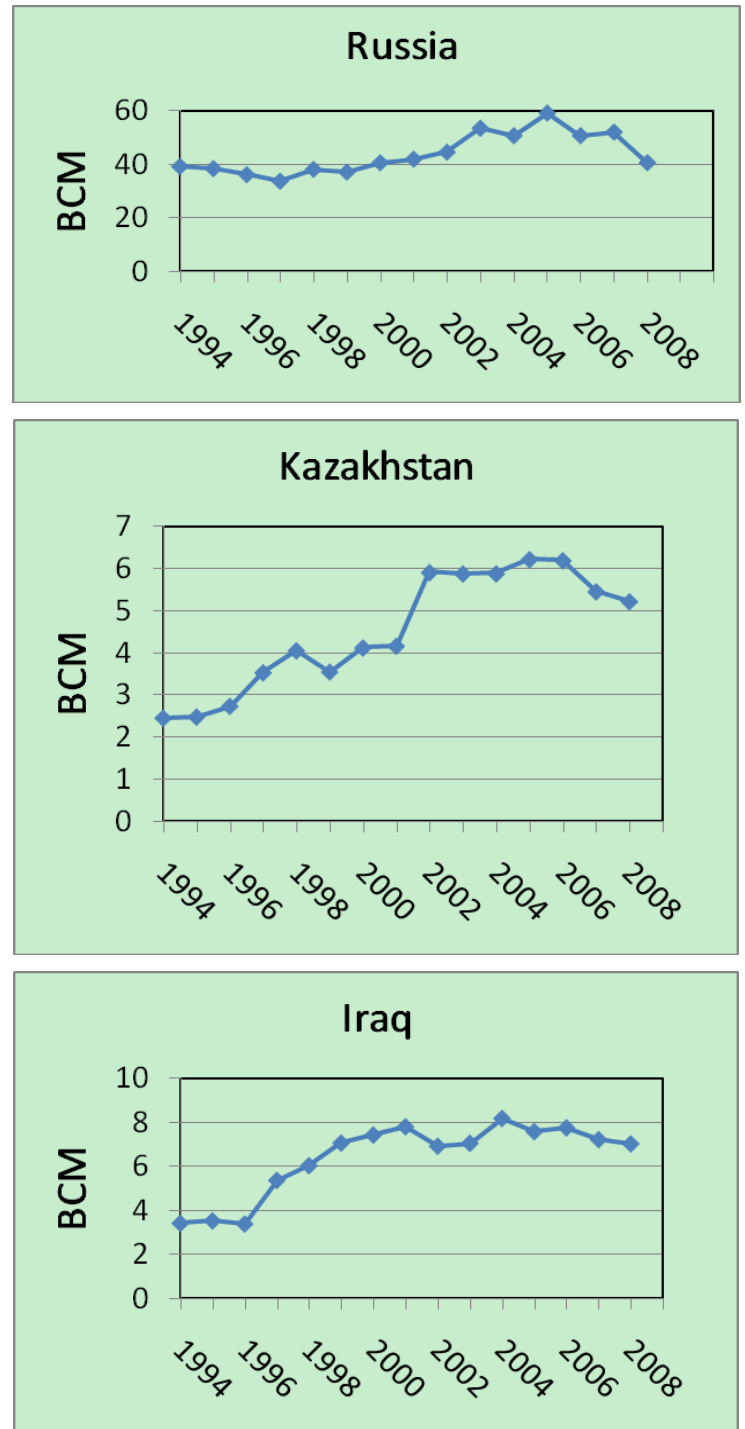
Figure 14. Russia, Kazakhstan and Iraq were three of the seventeen countries where gas flaring volumes increased from 1994 to 2005. Gas flaring declined in all three countries from 2005 through